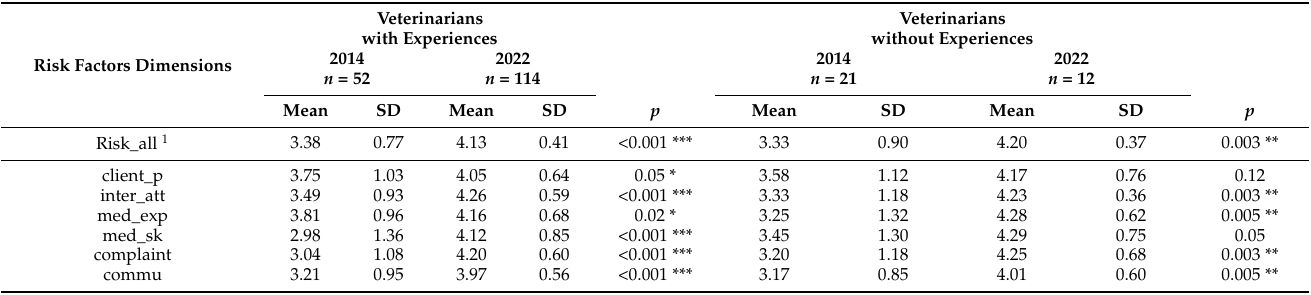
Table 11. Comparisons of the risk factor perceptions differences between 2014 and 2022 for veterinar- ians with/without experiences